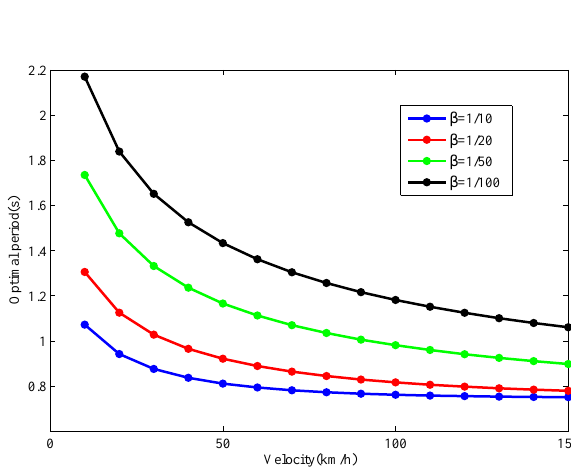
Figure 1. Optimal periods of the broadcast messages under different vehicle density and velocity distributions